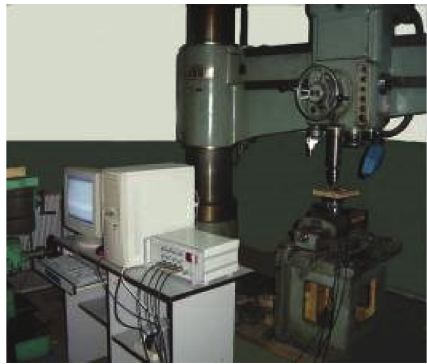
Figure 3: Z3040 radial drilling